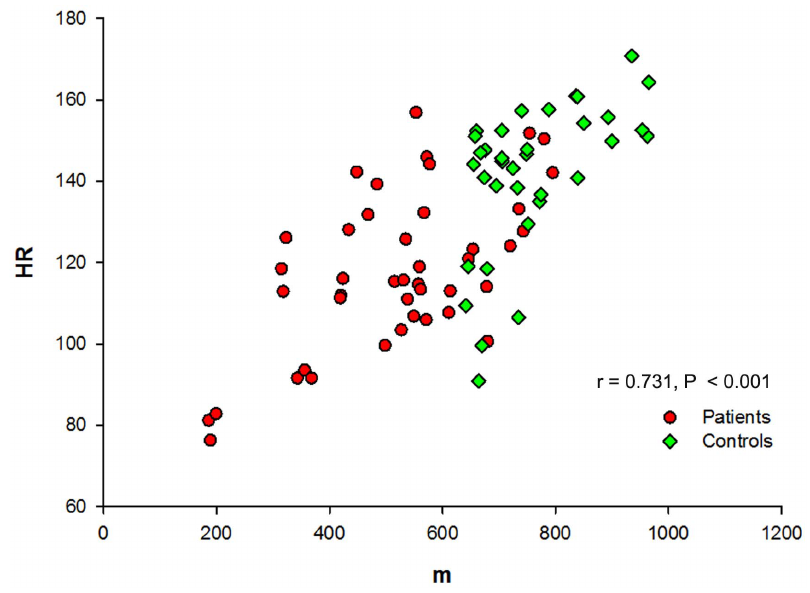
Figure 2. Correlation between heart rate and 6-minute walk distance. The graph shows the Pearson’s correlation between heart rate and walked distance for both patients and controls.